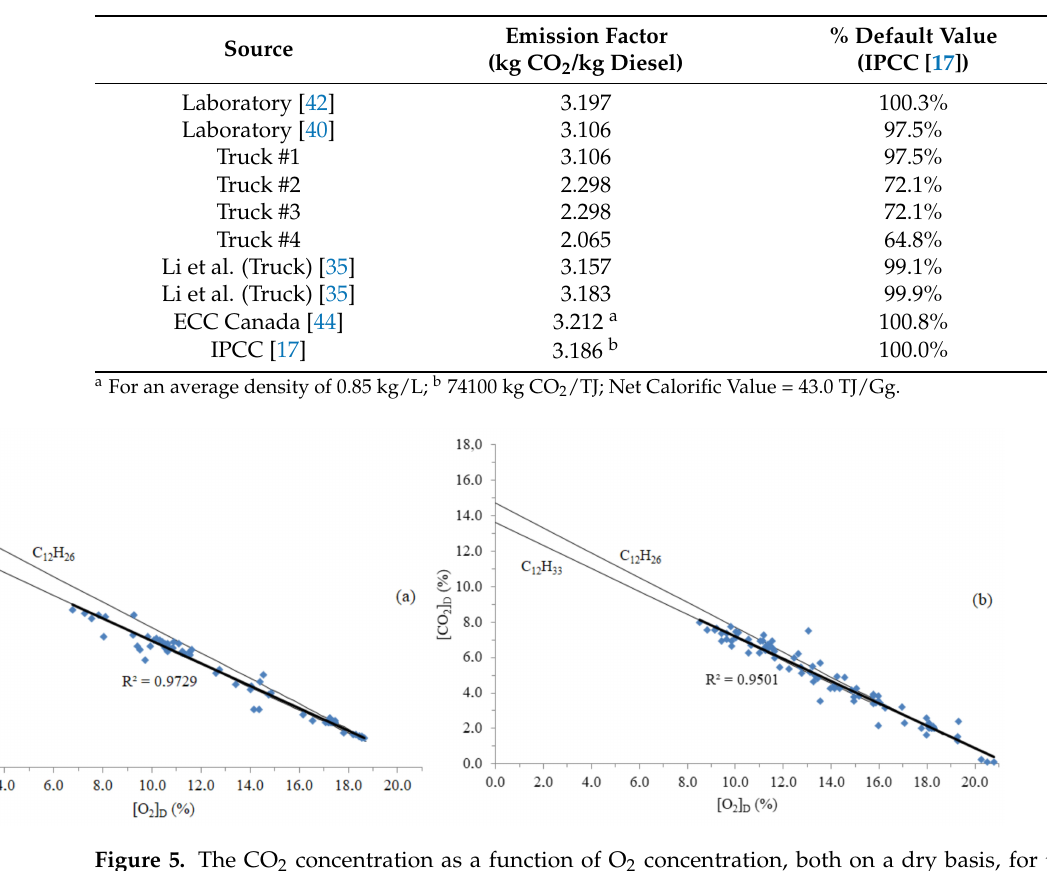
Figure 5. The CO 2 concentration as a function of O 2 concentration, both on a dry basis, for the combustion of diesel fuel in Trucks #2 and #3 at selected periods of operation; #2: 1260–2110 s ( a ); #3: 990–1830 s ( b